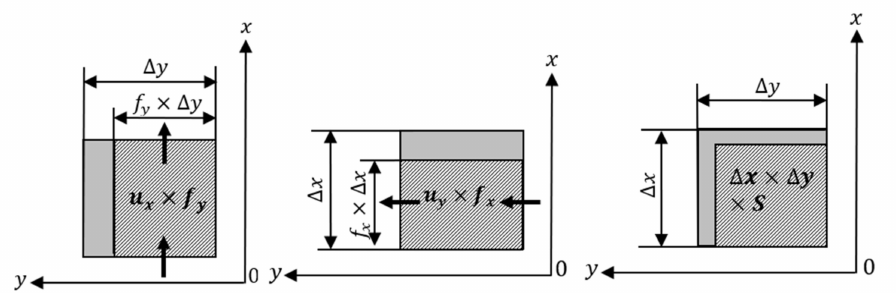
Figure 2. Explanation of f x , f y and S in a control volume. The shaded area shows wet portion. The gray area shows dry